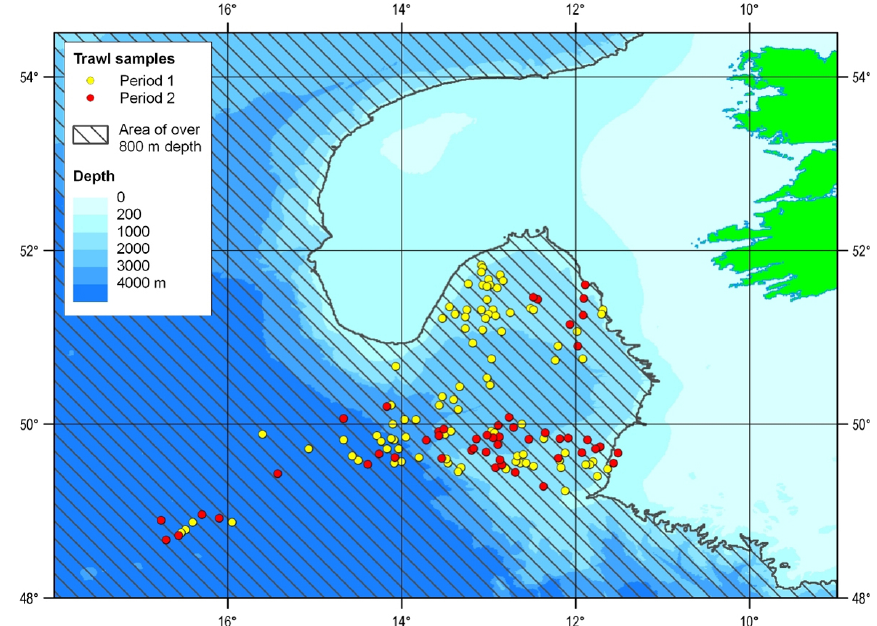
Fig. 1. Locations of the trawl stations. Period 1 (early period), pre-fishery years 1997–1989, period 2 (late period) during the commercial fishery years 2000–2002. 800m indicates the minimum depth sampled in this